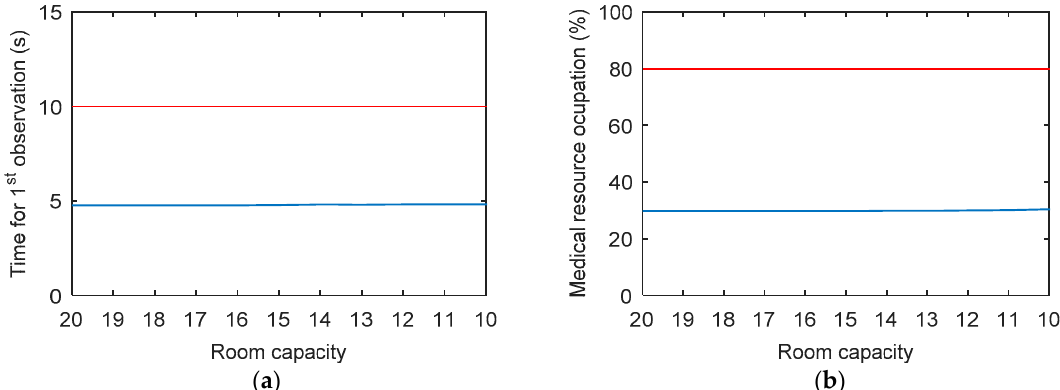
Figure 16. Obtained values for different capacity scenario: ( a ) waiting time for first medical intervention (blue line — simulation model, red line — Manchester time); ( b ) medical resource occupation (blue line — simulation model, red line — occupation rate limit).